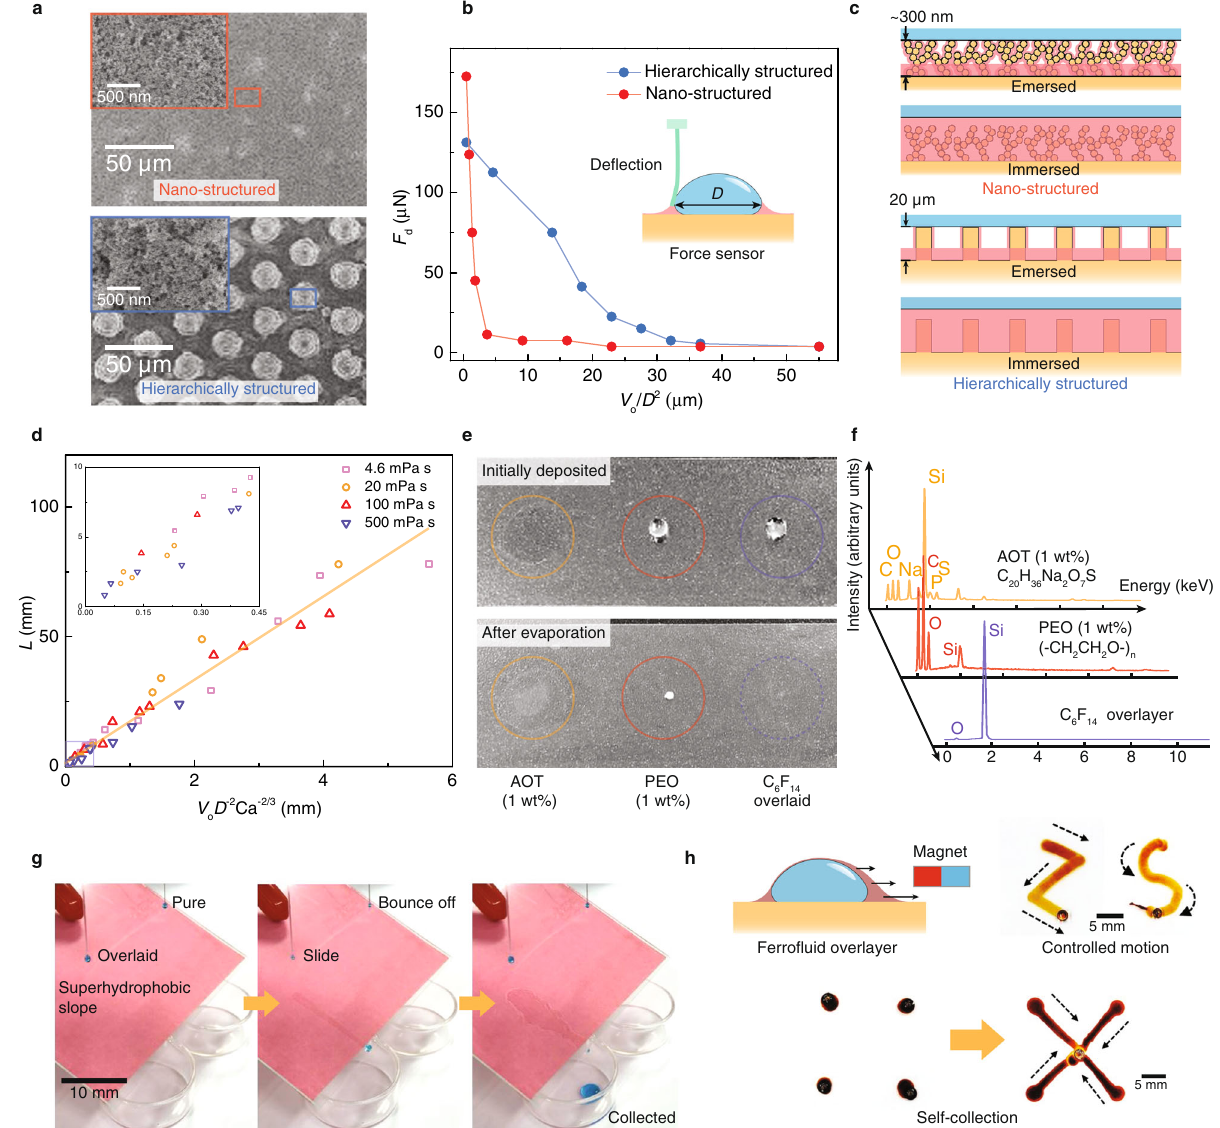
Fig. 5 Post-deposition liquid control. a SEM images showing the asperities on the nano-/hierarchically textured surfaces. b The depinning force as a function of the equivalent subjacent lubricant thickness V o D − 2 . Insets are schematics showing the detection of depinning forces. c Schematics showing the criterion for the state transition between pinned and sliding surfaces in ( a ). d The data collapse into a single curve for different systematic parameters, showing a linear relationship between the sliding distance and V o D − 2 Ca − 2/3 . The orange line is the linear fi tting line with a slope of 16.0. e Images showing the residues left by different deposition enhancing strategies. Compared with white stains using polymer additives, the volatile overlayer leaves no footprint. f Energy-dispersive spectroscopy con fi rms the composition of the polymer residues. g Demonstration of the liquid collection below a superhydrophobic slope. The overlayer suppresses the out-of-plane bouncing but enables in-plane sliding of water droplets. h Schematic and demonstrations showing the active control of overlaid